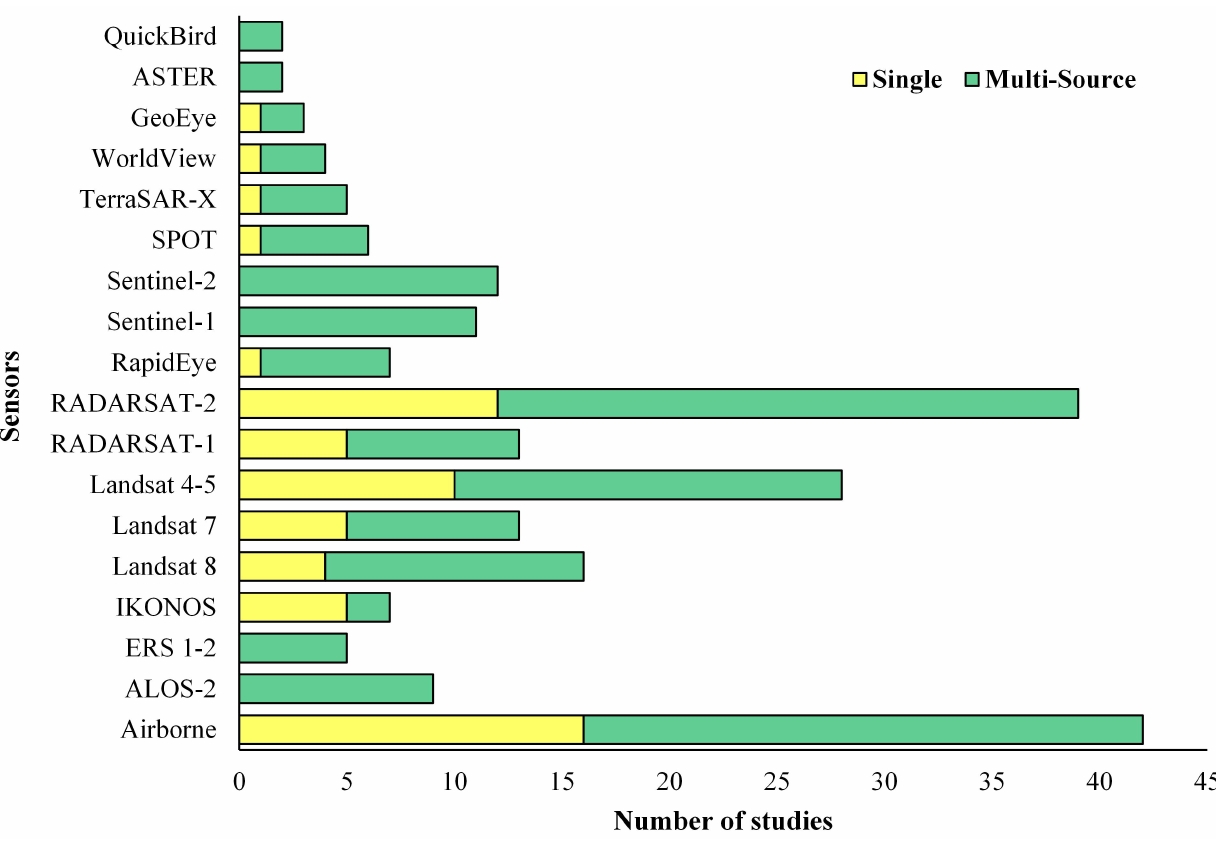
Figure 16. Frequency of different sensors used in RS-based wetland classification studies in Canada. Blue and red bards indicate if a single or multi-source data are